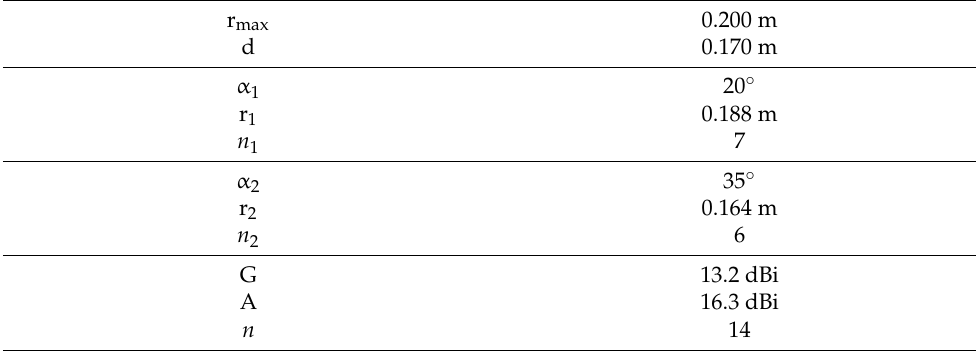
Table 1. The calculated values obtained in optimization for a frequency f = 1 kHz.